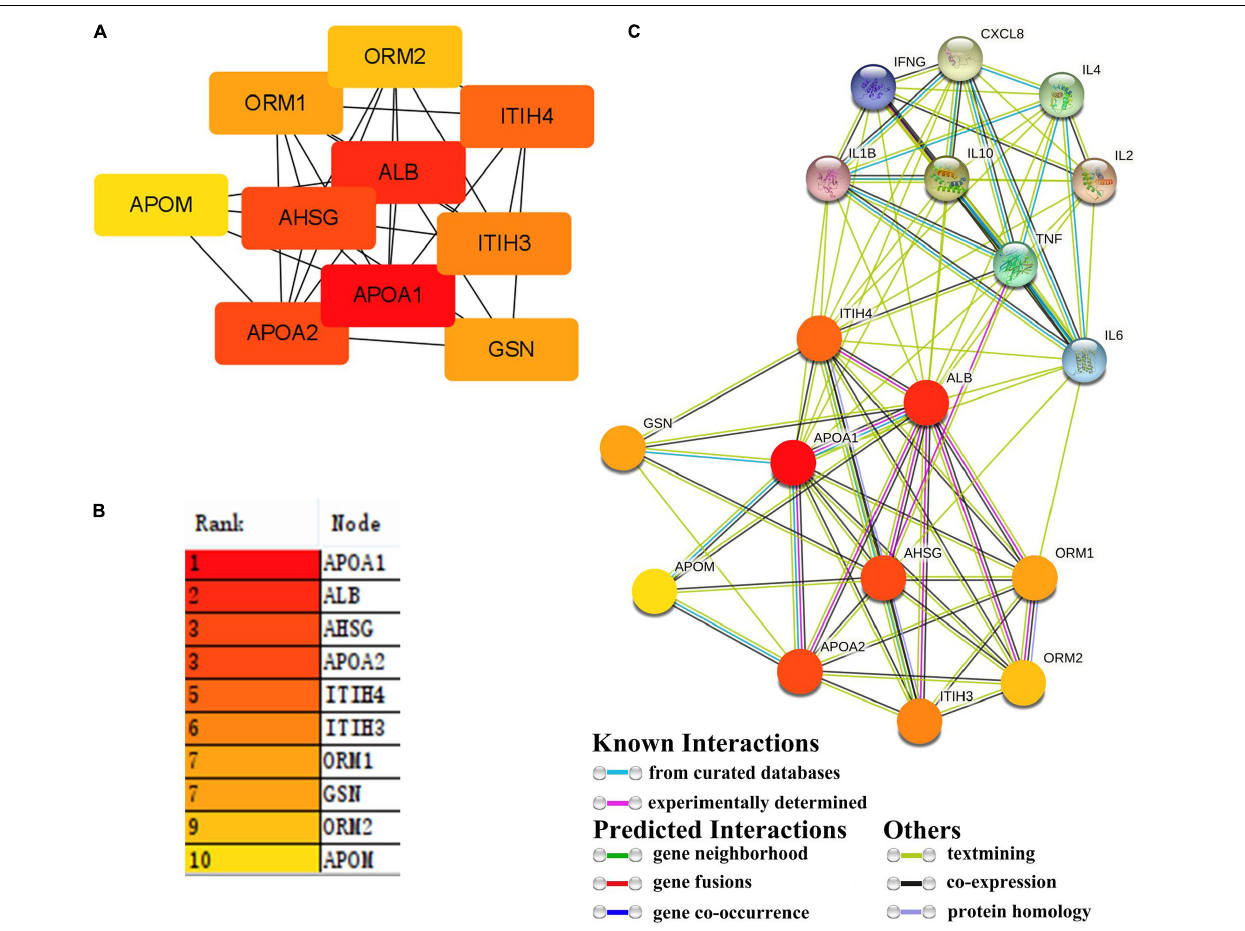
FIGURE 4 | Hub protein in 21 proteins and interaction between hub proteins and cytokines. (A,B) 21 proteins were screened for 10 hub proteins. (C) The interaction between hub proteins and